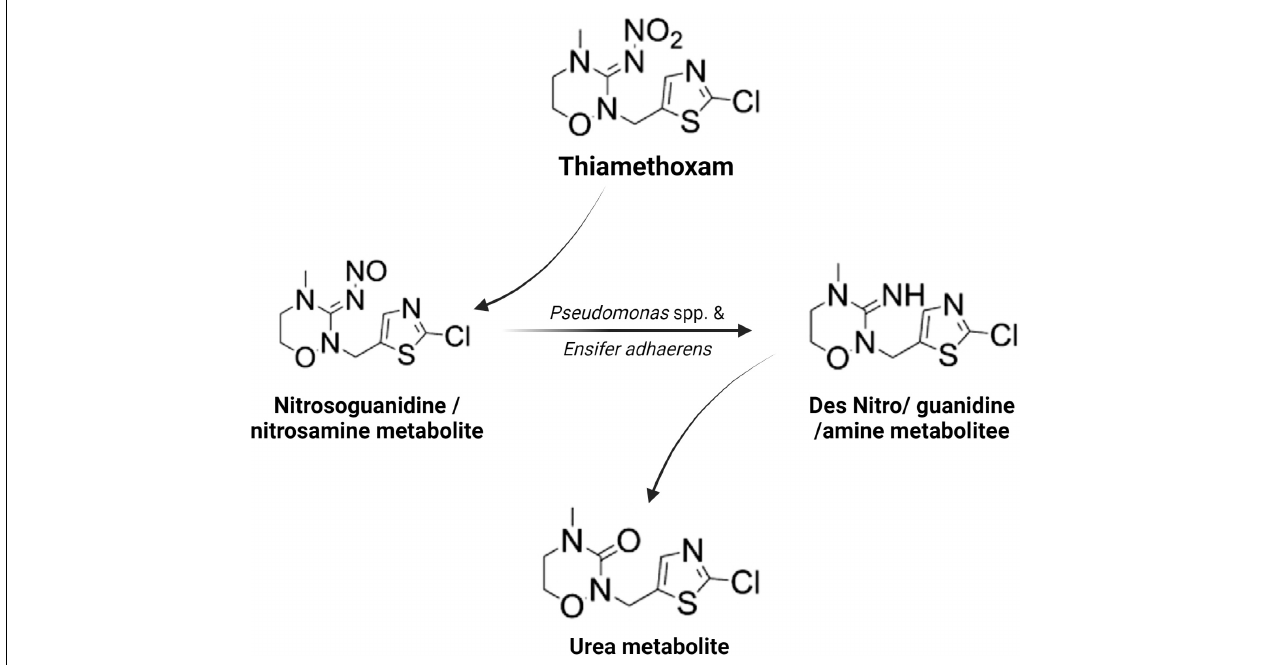
FIGURE 3 | Metabolic routes for bacterial degradation of the insecticide thiamethoxam (Hussain et al.,